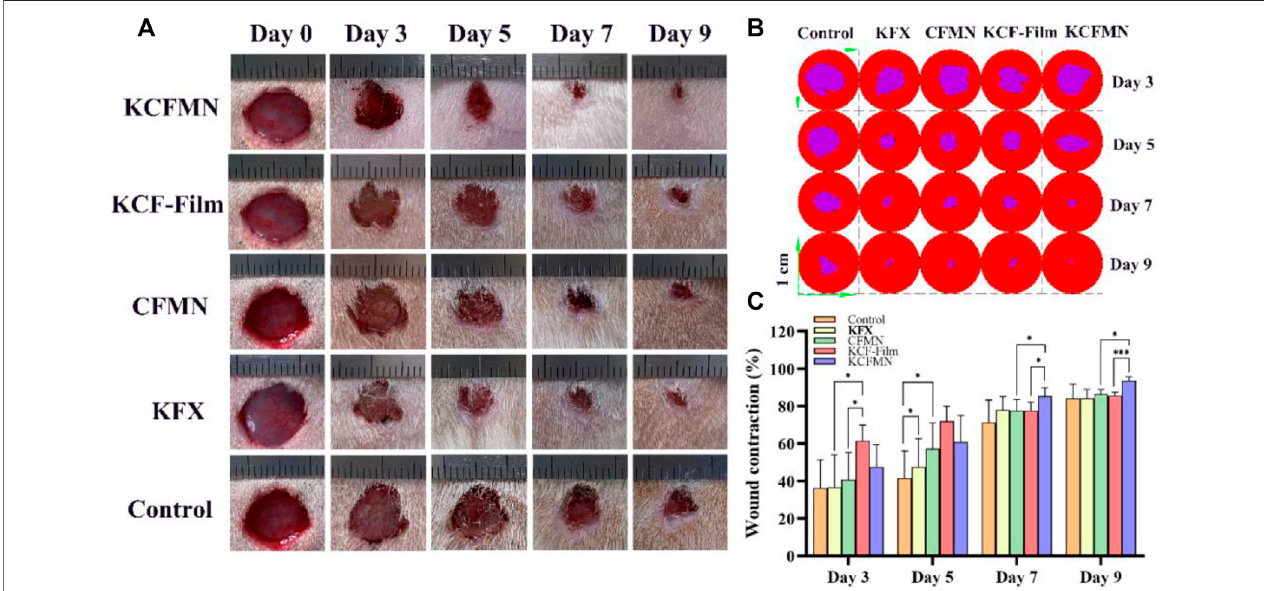
FIGURE 5 | (A) Representative images of the wounds treated by KCFMN, KCF-Film, CFMN, KFX, control group on days 0, 3, 5, 7, and 9. (B) Traces of wound closure for 3 – 9 days. (C) Wound contraction for 3 – 9 days (* p < 0.05 and *** p < 0.001).